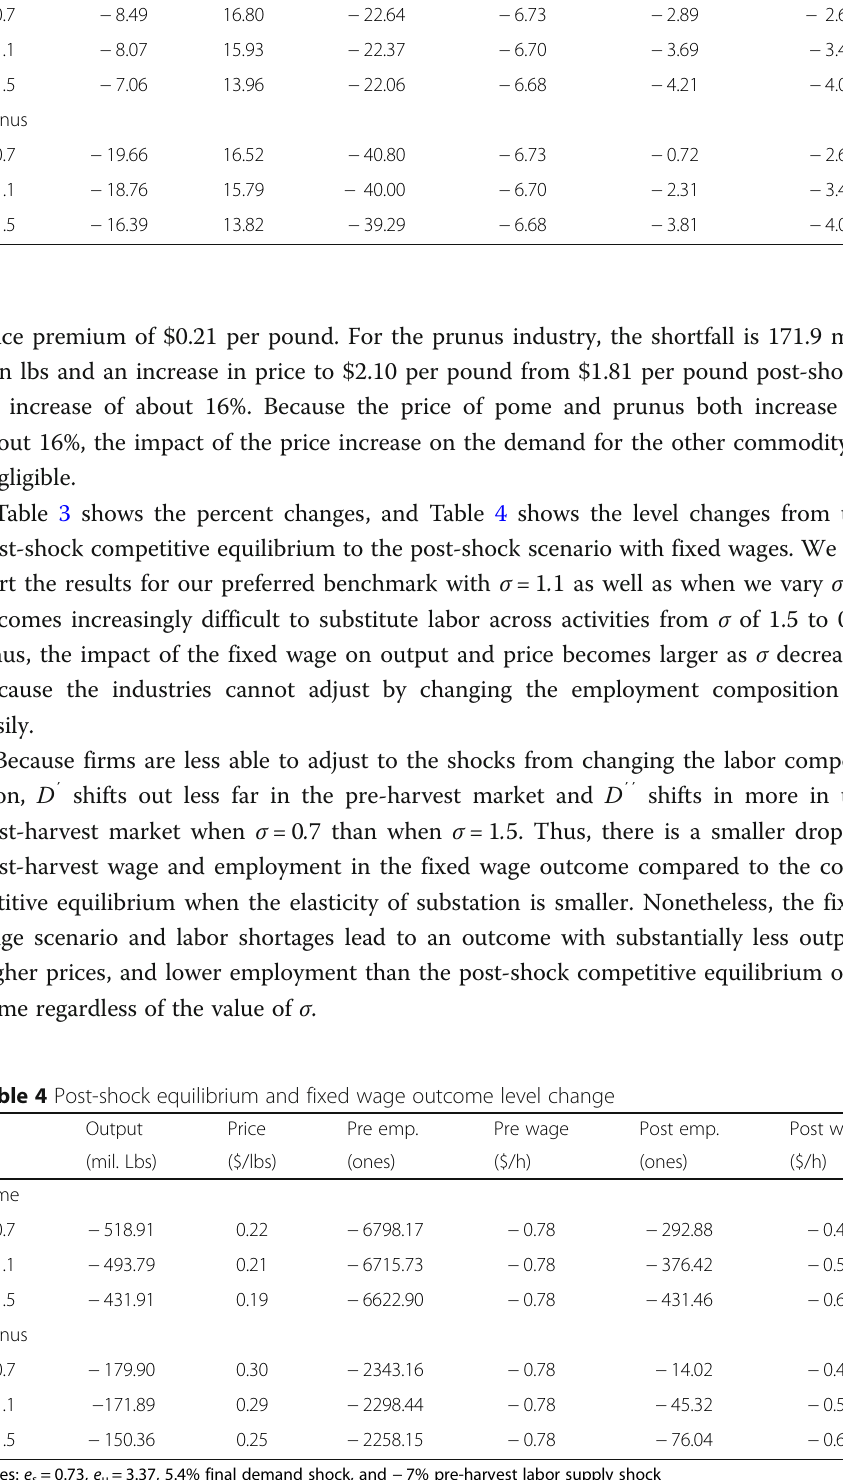
Table 3 Post-shock equilibrium and fixed wage outcome percent change σ Output Price Pre emp. Pre wage Post emp. Post wage (Percent change) Pome